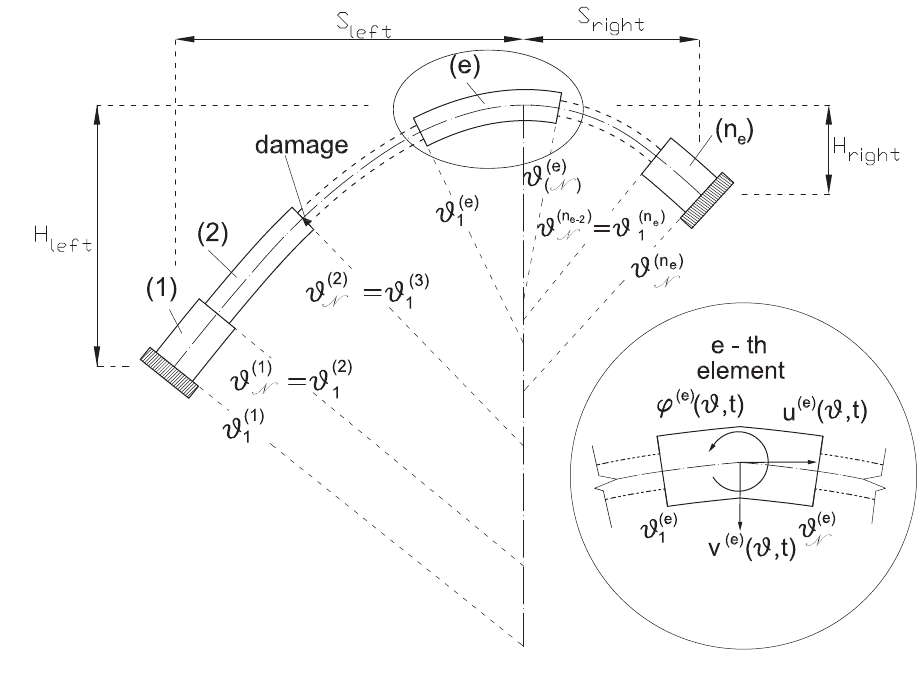
Figure 3: Schematic representation of the multi-stepped parabolic arch.